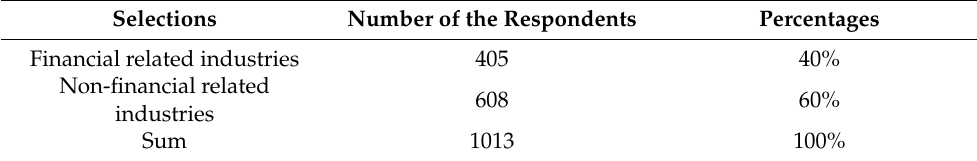
Table A3. Are you working in the financial related industries (single-choice question)?